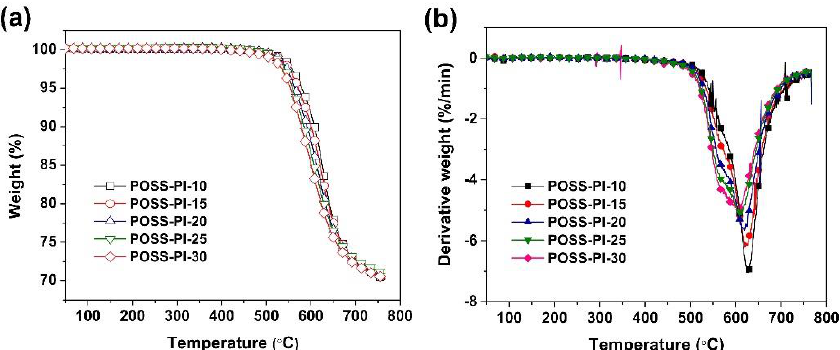
Figure 8. Thermal decomposition of POSS-PI composite films at a heating rate of 10 K/min under nitrogen flow. ( a ) TGA; ( b ) DTG. Table 3. Thermal properties of POSS-PI composite films.